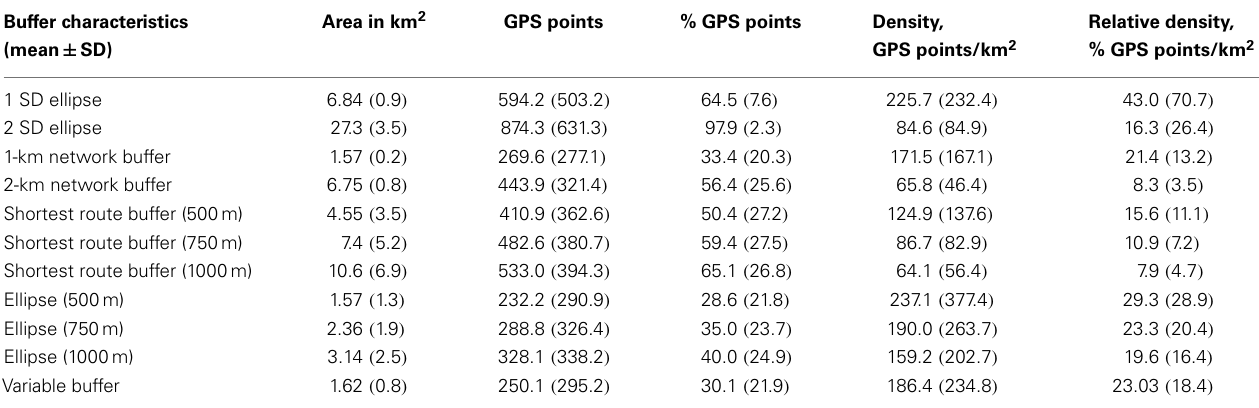
Table 3 | Buffer area, GPS points, percentage GPS points, density (GPS points per square kilometer), and relative density (percentage GPS points per square kilometer) .